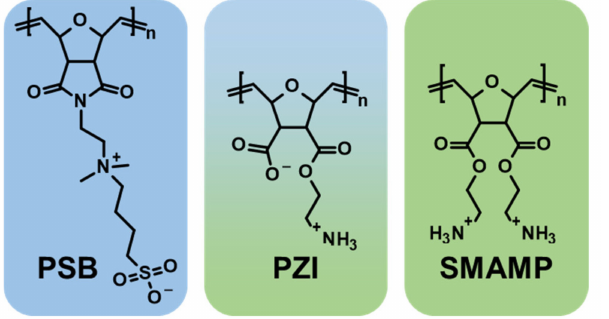
Figure 1. The effect of polymer coatings made from the protein-repellent PSB, the protein-repellent and antimicrobial PZI, and the mildly antimicrobial SMAMP on the growth and microbial composi- tion of oral biofilms was